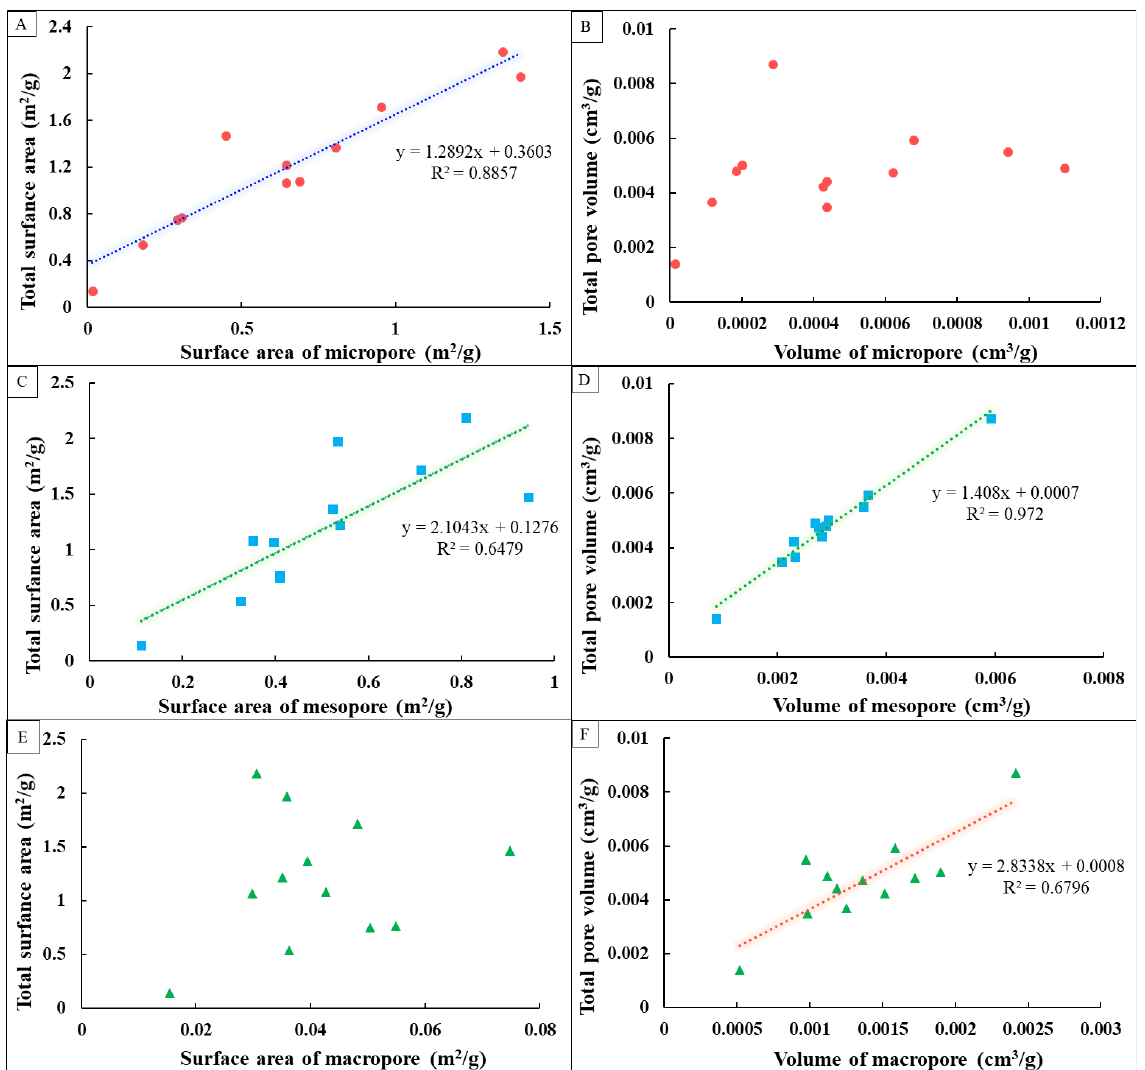
Figure 9. ( A ) Correlations between total surface area and surface area of micropore in the study area. ( B ) Correlations between total pore volumes and volume of micropore in the study area. ( C ) Correlations between total surface area and surface area of mesopore in the study area. ( D ) Correlations between total pore volumes and volume of mesopore in the study area. ( E ) Correlations between total surface area and surface area of macropore in the study area. ( F ) Correlations between total pore volumes and volume of macropore in the study area.